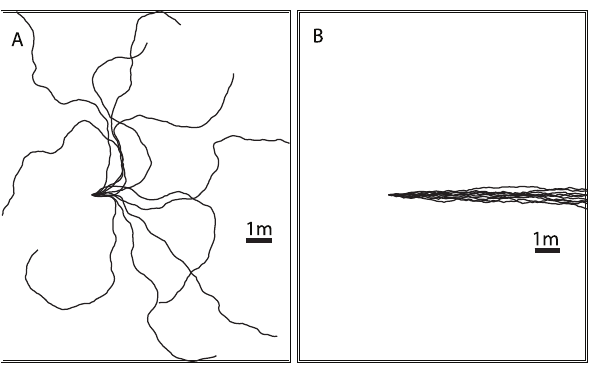
Figure 13. The effects of noise. A) A random walk with normally distributed noise with a standard deviation of & 15 o added to the current heading at each timestep and a stepsize of 10 cm. B) A directed walk with a fixed heading of 0 and normally distributed noise with a standard deviation of & 15 o added at each timestep with a stepsize of 10